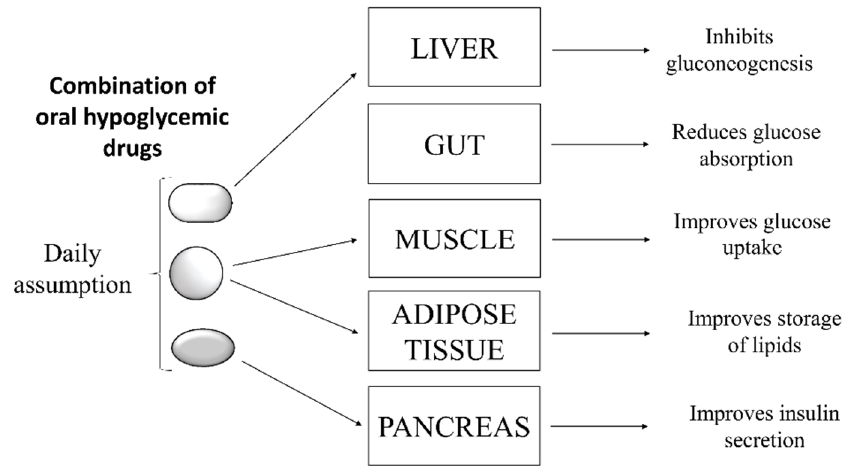
Figure 2. Antidiabetic strategy based on combination therapy: patients are treated with two or more antihyperglycemic oral drugs also administered at different times of the day.